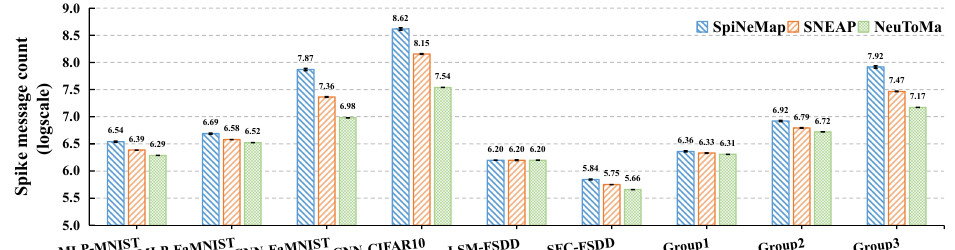
Figure 7. The total number of spike messages on